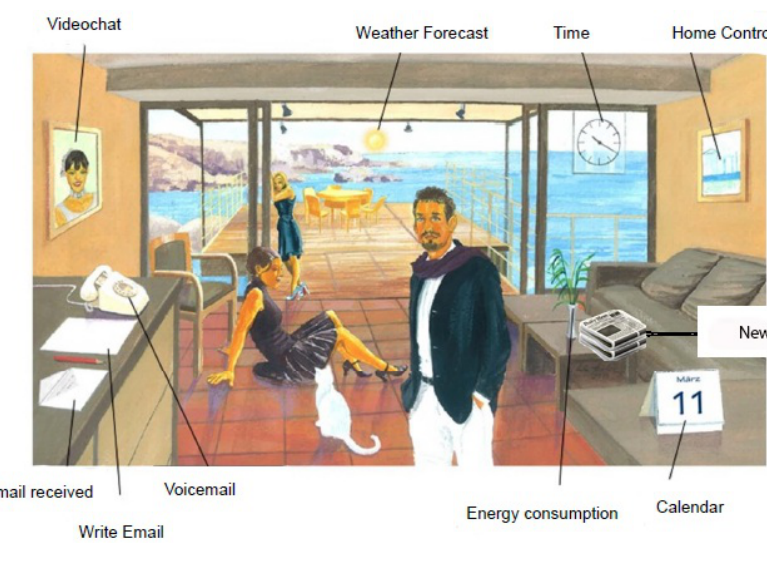
Figure 5. Overview of available interactive features.